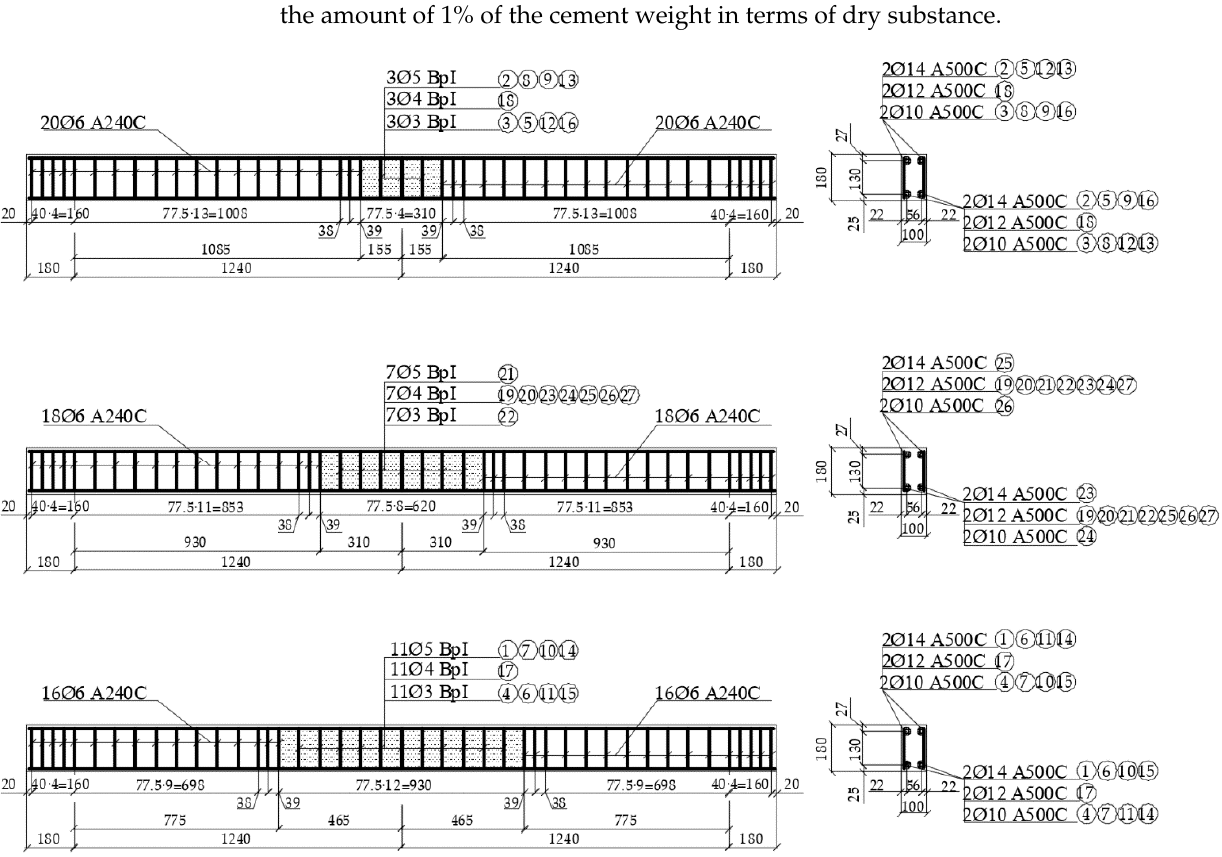
Figure 1. Design and reinforcement of continuous reinforced concrete beams ( V series). I — experience number.